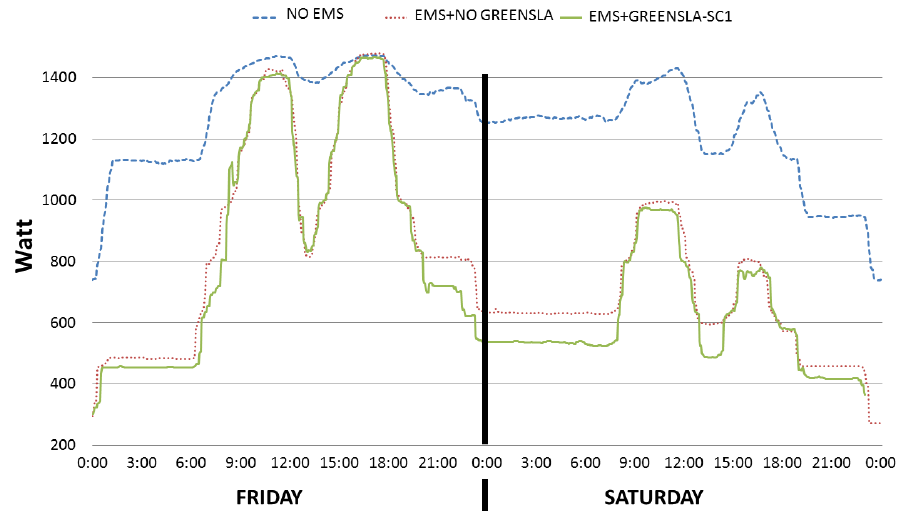
Figure 5. Power consumption (Watt) of the tested “Baseline Scenario”.